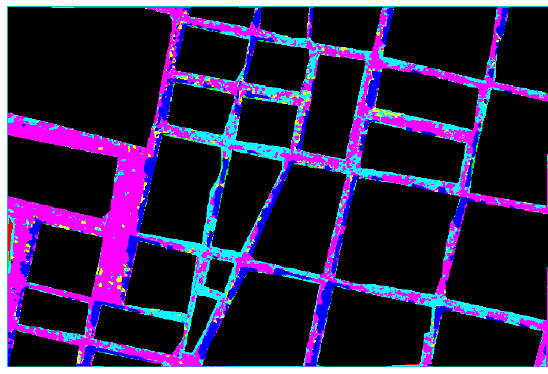
Fig 5. Image classification after quake After classification and extraction of path regions based on the aforementioned approach, the potential blockage of paths is detected. Fig.6 shows some of the paths which are not considered blocked, while Fig.7 depicts the paths which are considered as blocked ones by the algorithm.